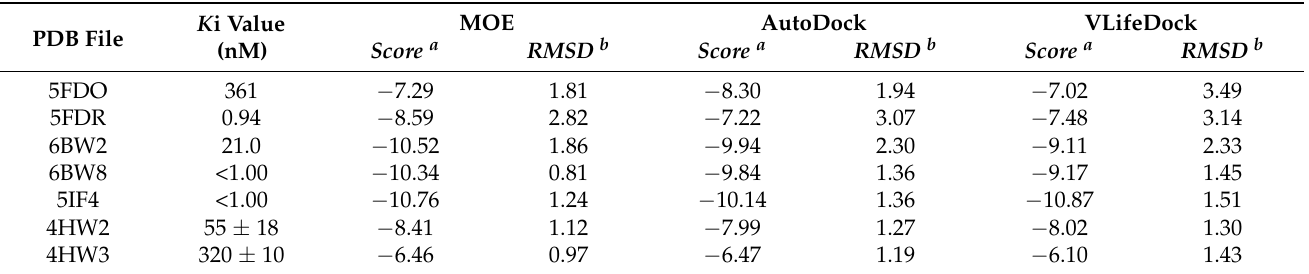
Table 4. Comparison of scores from self-docking using various methods with hMcl-1 inhibitor K i